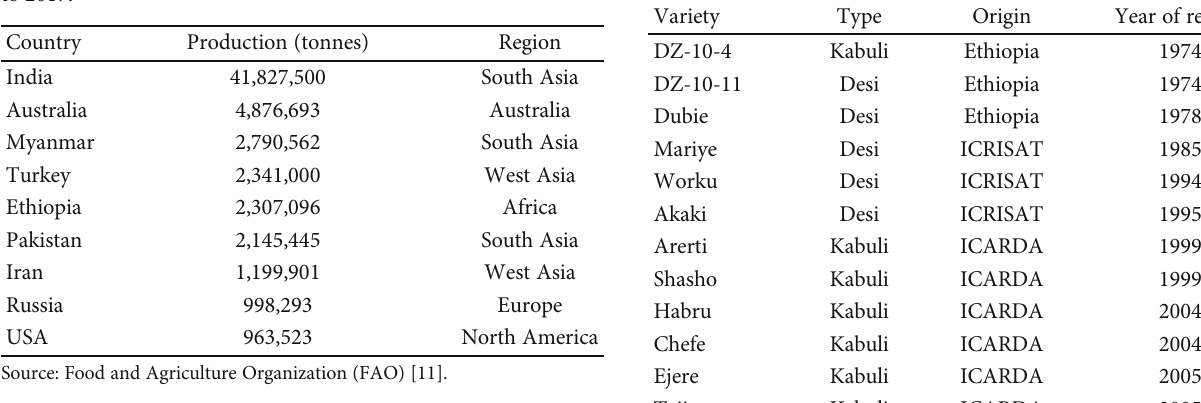
Table 2: Chickpea varieties released in Ethiopia